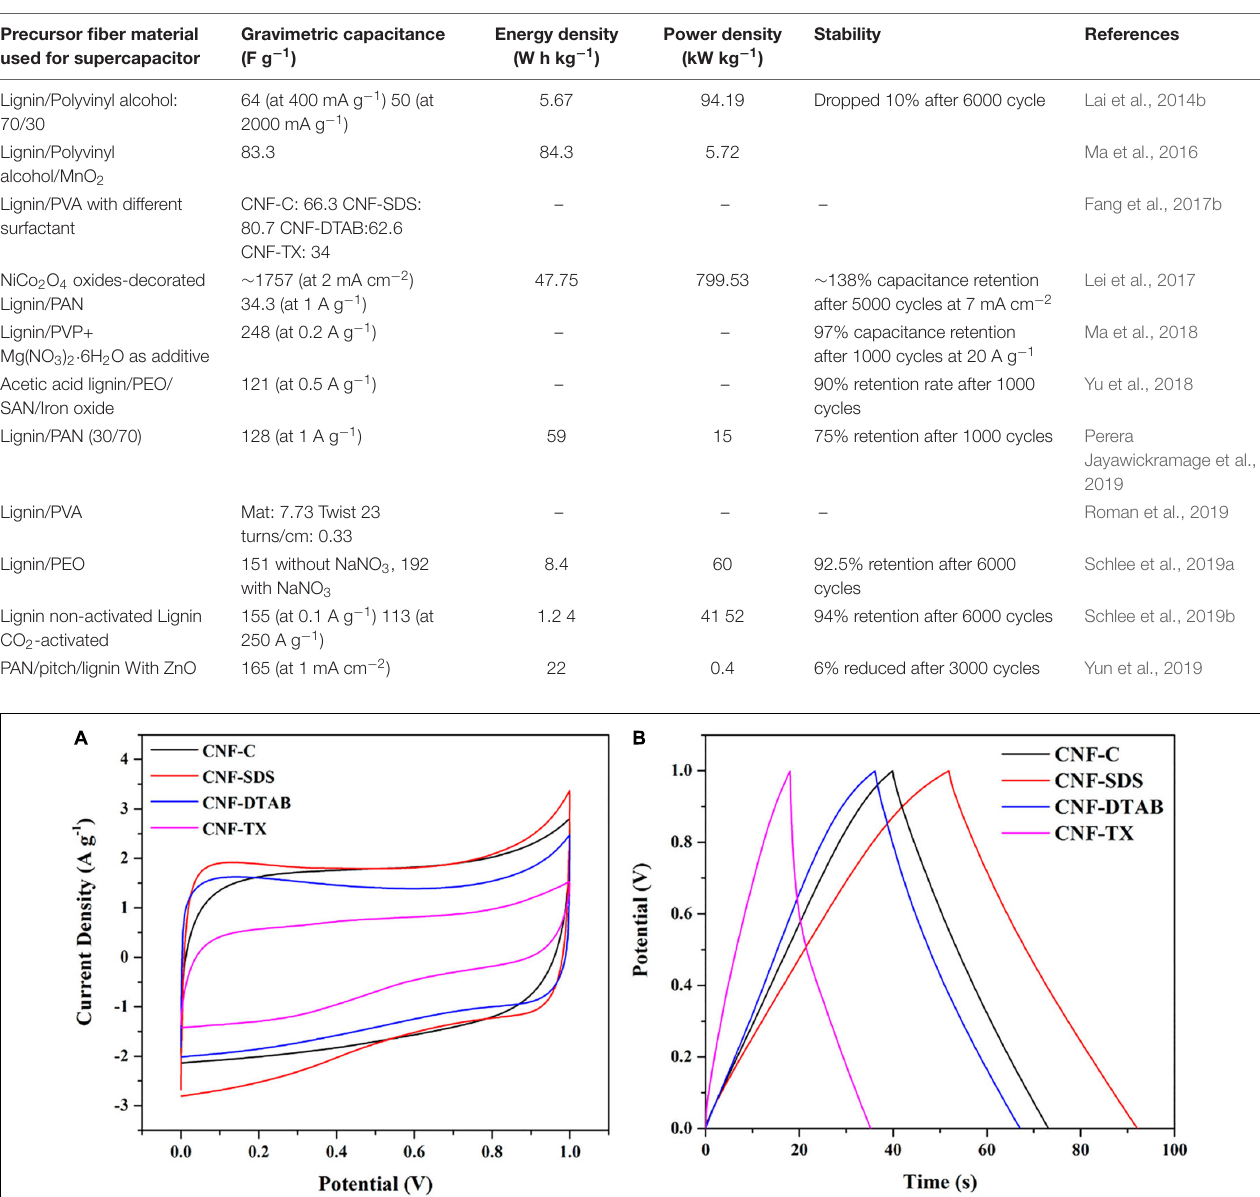
TABLE 4 | Electrochemical properties of carbonized fibers as supercapacitor. Precursor fiber material used for supercapacitor